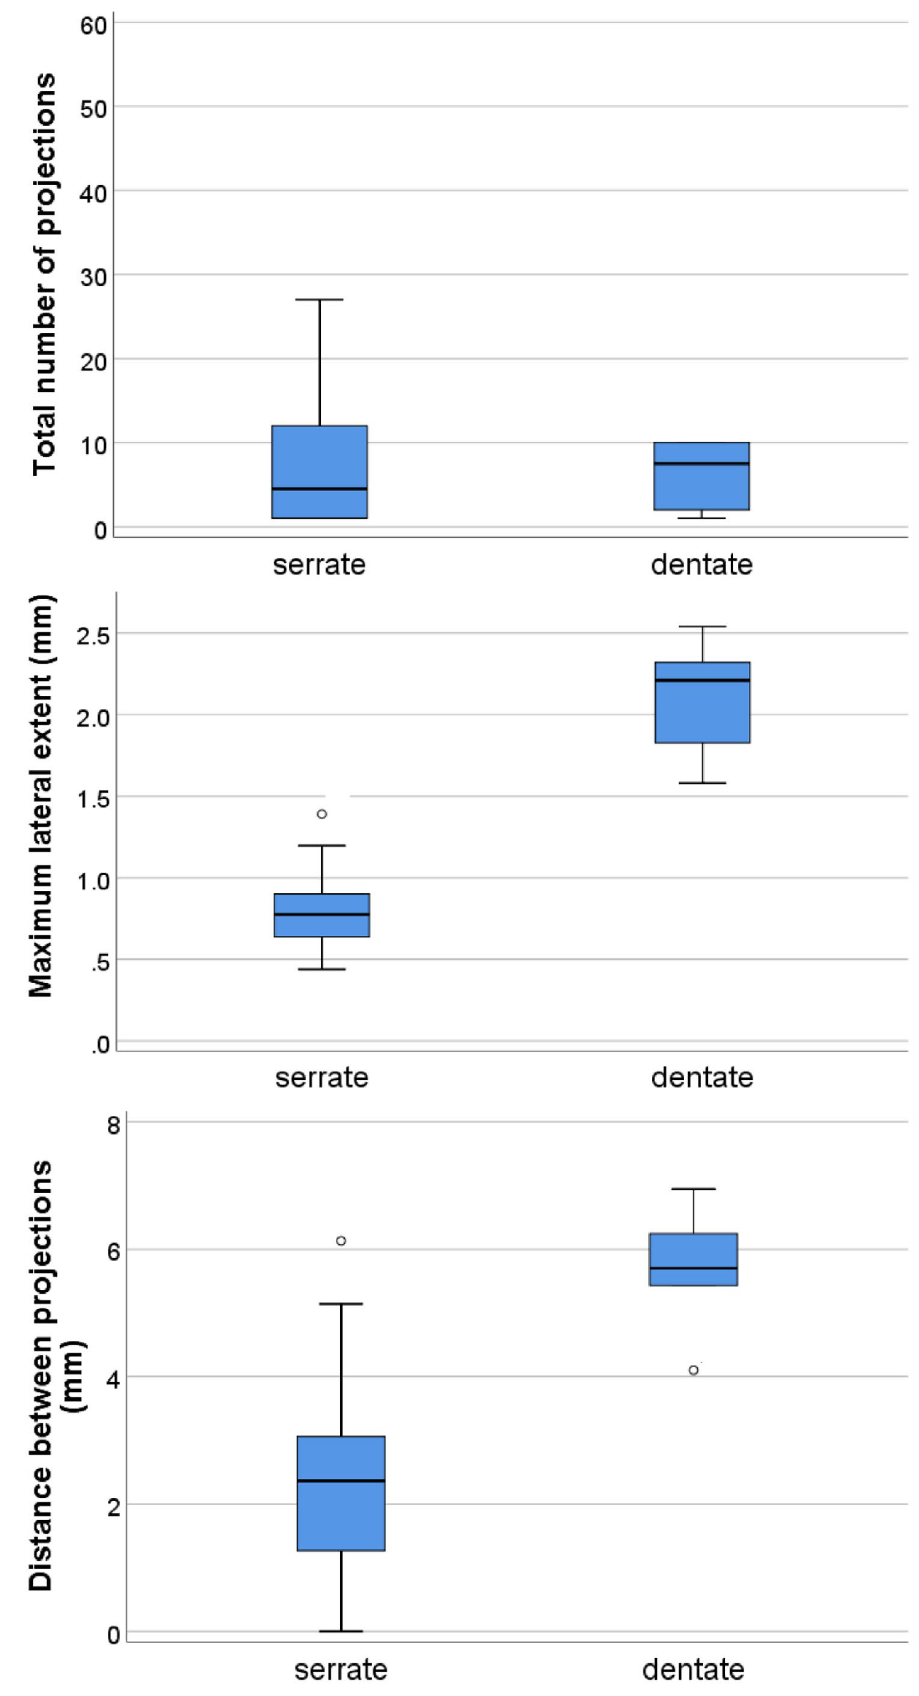
Figure 11. Metric variation of projection